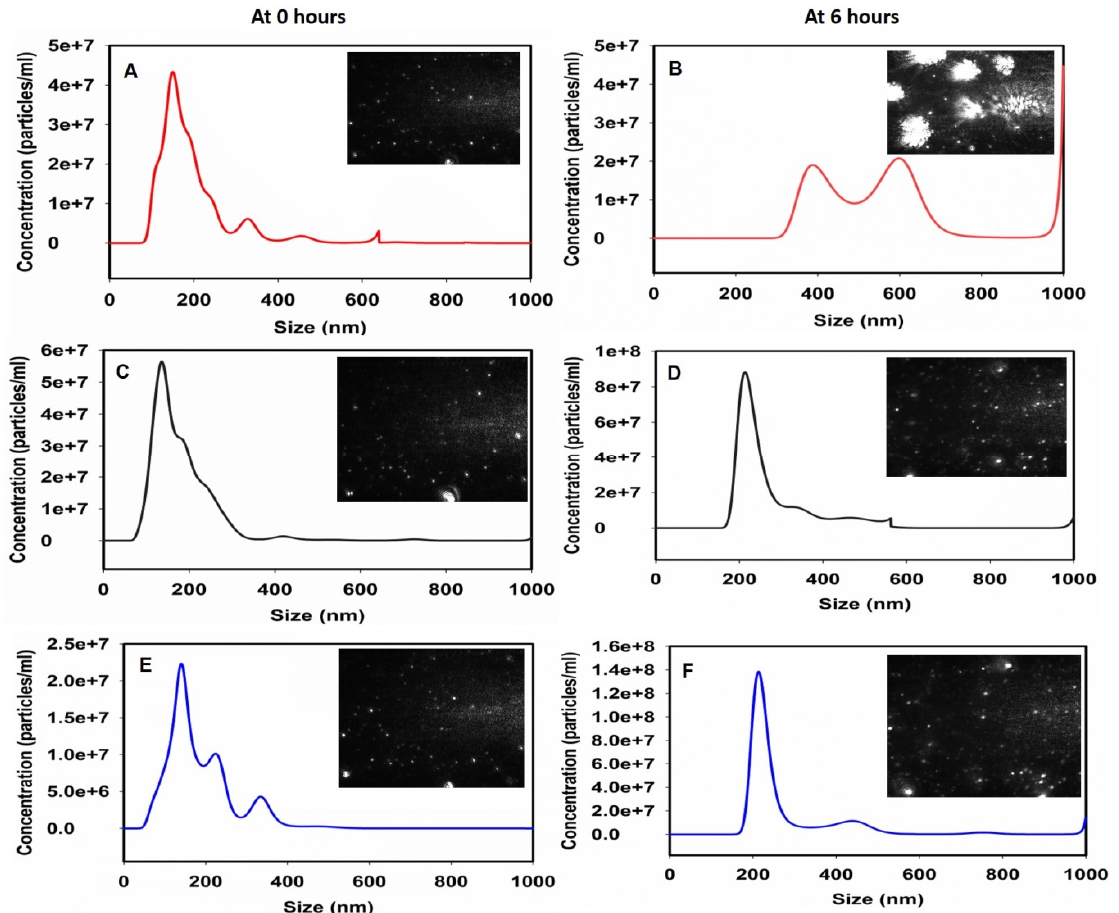
Figure 5. Nanoparticle tracking analysis (NTA) size measurement experiments to observe the biomineralization. ( A ) Tooth protein extract at 0 h. ( B ) Tooth protein extract in the presence of calcium phosphate at 6 h. ( C ) Dephosphorylated tooth protein extract at 0 h and ( D ) depicts the 6 h image in the presence of calcium phosphate. ( E ) Deglycosylated tooth protein extract at 0 h and the corresponding mineralization e ff ect after 6 h is seen at ( F ). All the figures have inset showing representative images taken by NTA attached camera at 0- or 6-h time points.